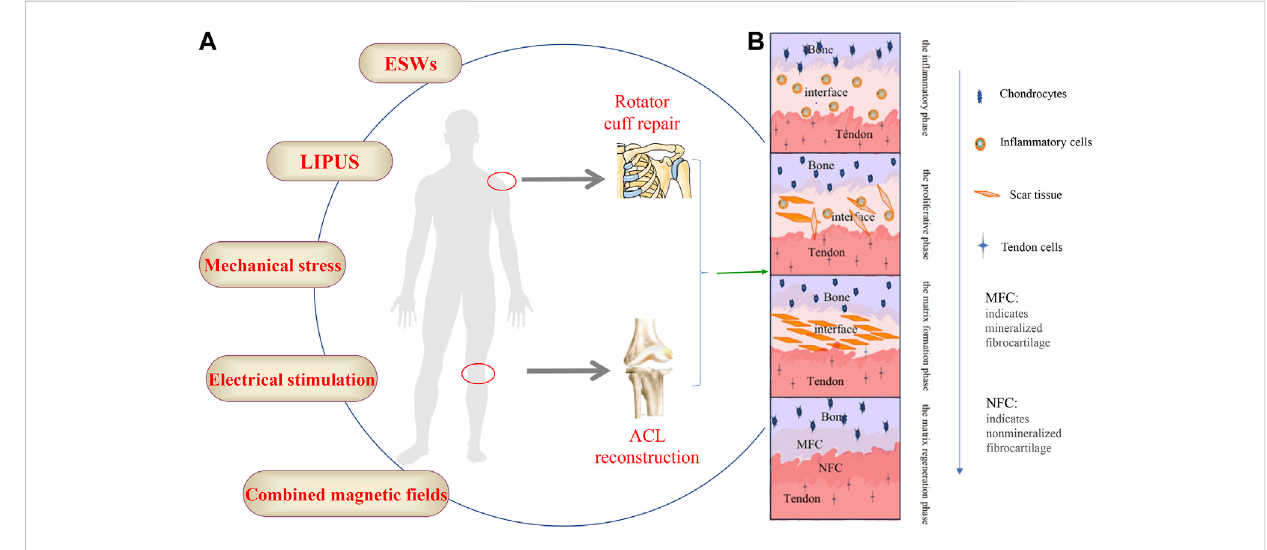
FIGURE 1 (A) The schematic diagram of the external stimulation methods, (B) The four stages of the bone-tendon healing